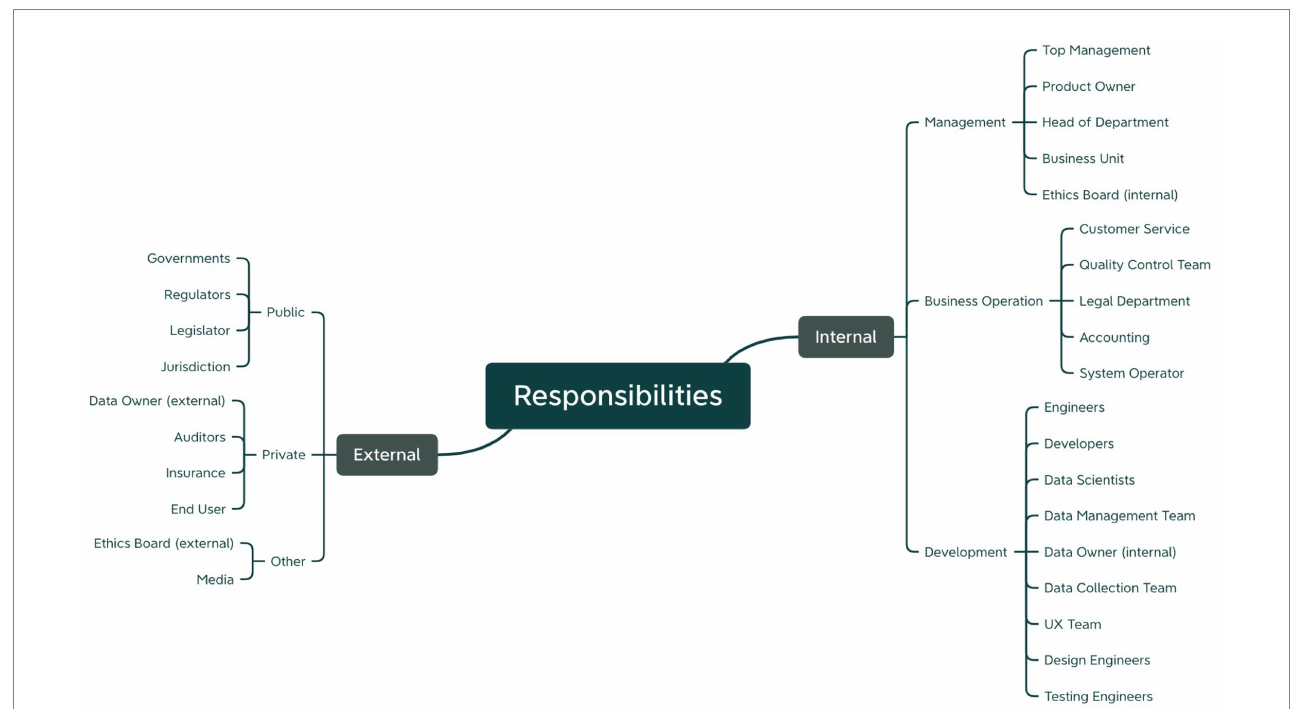
FIGURE 11 Summary of responsible actors determined for each step of the prototyped risk management